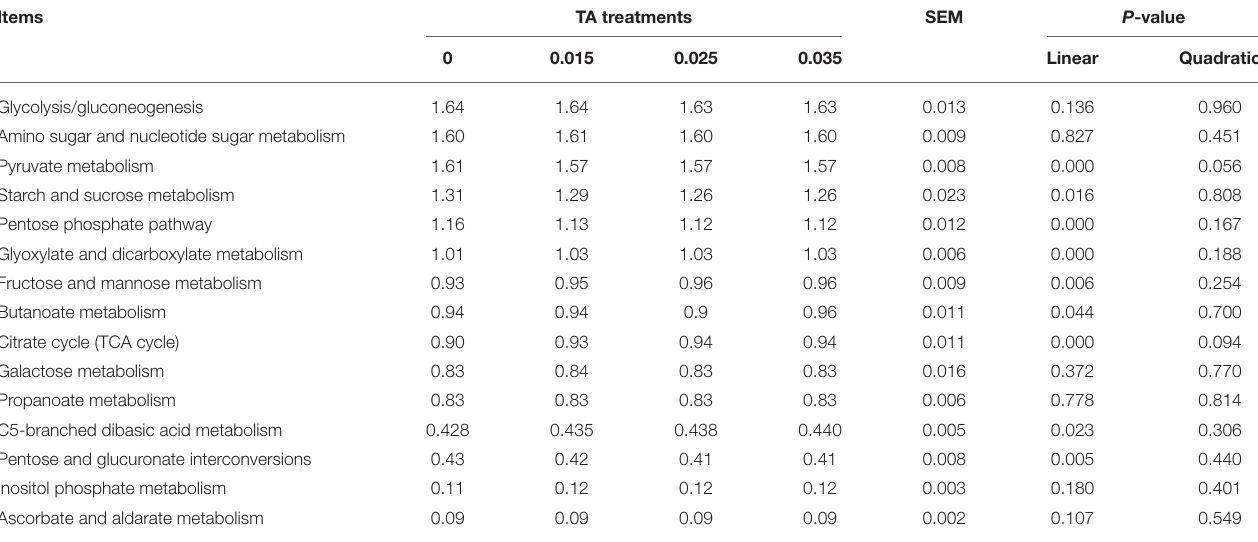
TABLE 6 | Effects of tannic acid concentration treatments of ground corn on the altered abundances of carbohydrate metabolic pathways (%) in level 3 KEGG. Items TA treatments